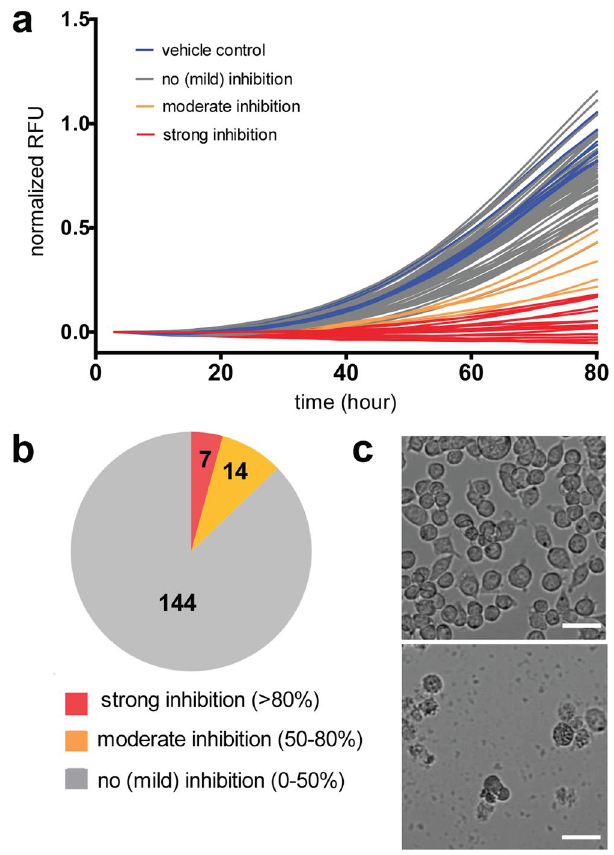
Figure 2. Characterization of cytotoxic activities of GSK TB-set compounds. ( a ) Growth kinetics of D. discoideum GFP-ABD in HL5c medium and in the presence of 10 μ M corresponded compounds from GSK TB set. ( b ) Pie chart representing summarized results of growth inhibitory activity of 168 compounds in BV2 growth assay. The analysed set included compounds that displayed inhibition of more than 80% normalized RFU (red), moderate inhibition between 50 and 80% (orange), compounds that showed less than 50% inhibition (grey). ( c ) Bright-field microscopy of BV2 cells in the presence of non-cytotoxic compounds (upper image) of cytotoxic compounds (lower image. 10 5 BV2 cells were transferred to the wells, the measurements were taken after 60 hours of incubation. The scale bar corresponds to 500 µ